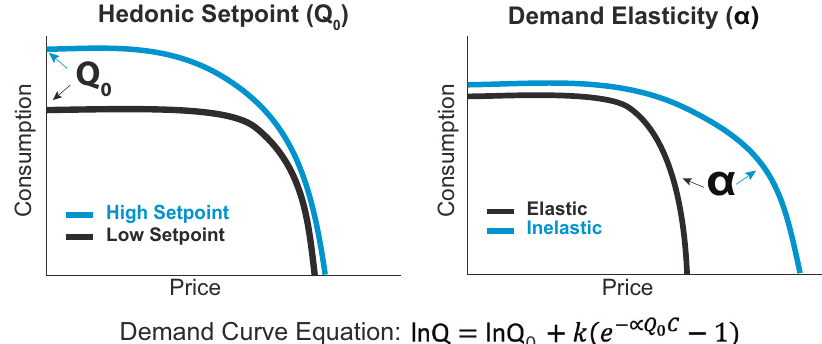
Fig. 1 Demand characteristics in sample curves. Schematic representation of sample demand curves generated from hypothetical response patterns re fl ecting differences in hedonic setpoint ( Q 0 ) and demand elasticity ( α ). Drug intake was determined at each response requirement and consumption data were modeled with an exponential demand equation: lnQ ¼ ln Q 0 þ k ð e (cid:2)/ Q 0 C (cid:2) 1 Þ [44, 60], where Q = consumption, C = unit cost, k is a scalar constant for consumption range, α = demand elasticity, and Q 0 = extrapolated intake at zero effort. This process yields a demand curve fi tted to consumption at each price, from which variables corresponding to the hedonic setpoint (Q 0 ) and motivation ( α ) are